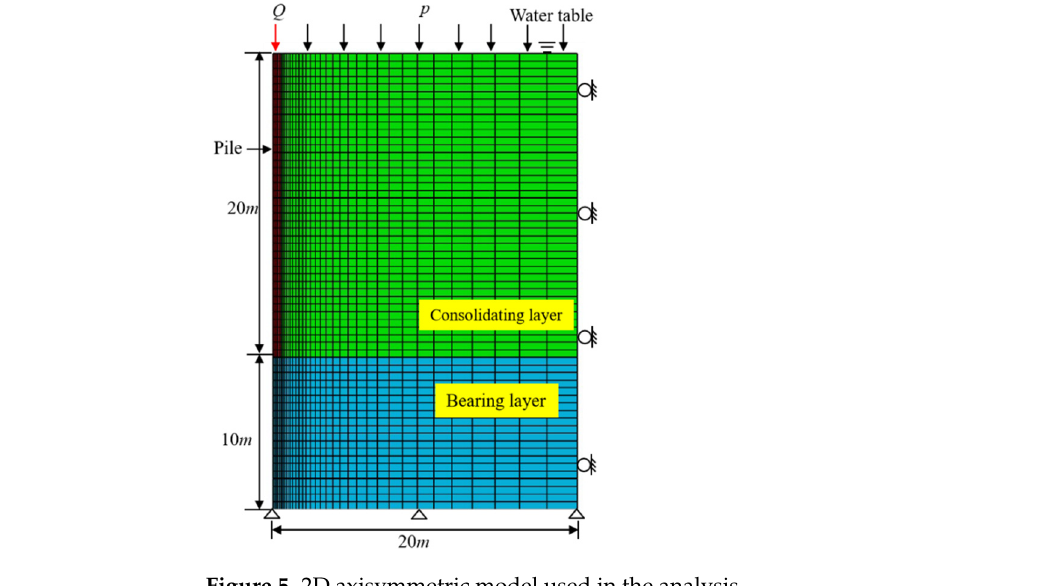
Figure 5. 2D axisymmetric model used in the analysis. Table 4. The parameters of the pile–soil system used in FEM model.